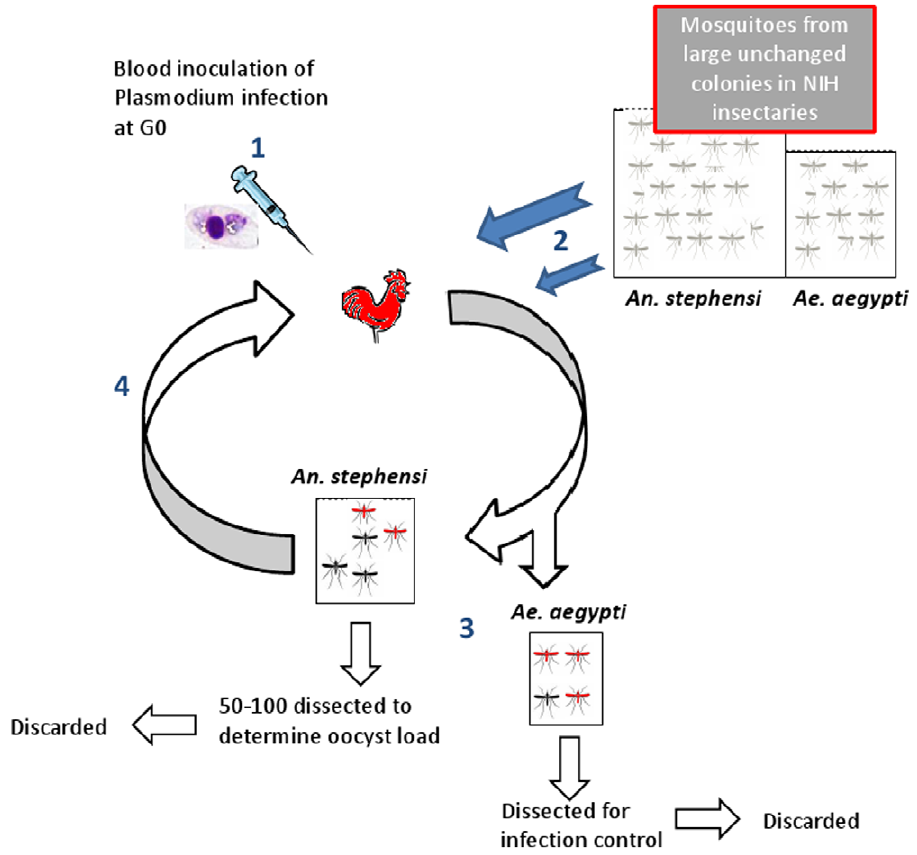
Figure 2. Selection protocol for increasing parasite compatibility. Schematic illustrating selection protocol for increased parasite compatibility (nPC) of P. gallinaceum infecting An. stephensi . (1) P. gallinaceum stock was injected into a chicken host, which was monitored until parasitemia reached near 10–20%. (2) Approximately 700 female An. stephensi mosquitoes randomly chosen from a large stock colony were fed on the infected chicken (side by side with 30–50 Ae. aegypti , used as positive control). (3) On day 6 p.i., a subset of the An. stephensi females (50 , N , 100) were dissected for determination of oocyst load in their midgut i.,e., red denotes infected and black denotes uninfected. (4) Infection of a new chicken by the parasite that completed its development in An. stephensi was produced by feeding of the remaining , 500 females on a new chicken host. The next parasite selection cycle started from step 2. Note that parasite selection is totally independent from mosquito selection because no infected mosquitoes were allowed to produce